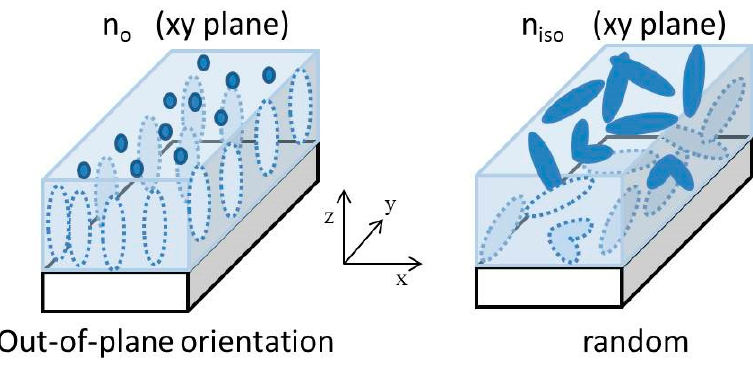
Figure 5. Refractive indices of the out-of-plane orientation and random state. The film plane (xy plane) is normal to the monitoring light.